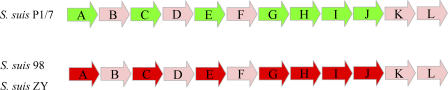
Comparison of the
cps2 Gene Clusters Involved in CPS-2 Synthesis
Exactly matched genes (5/12) include
cps2B, cps2D, cps2F,
cps2K, and
cps2L and are shown in pink. The seven other genes (which did not exactly match) include
cps2A cps2C, cps2E, cps2G, cps2H, cps2I, and
cps2J and were highlighted with green in
S. suis P1/7 and with red in both
S. suis 98 and
S. suis ZY. Amino acid abbreviations used are: A, alanine; C, cysteine; E, glutamic acid; F, phenyalanine; G, glycine; I, isoleucine; K, lysine; L, leucine; M, methionine; Q, glutamine; R, arginine; S, serine; V, valine; W, tryptophan; Y, tyrosine.